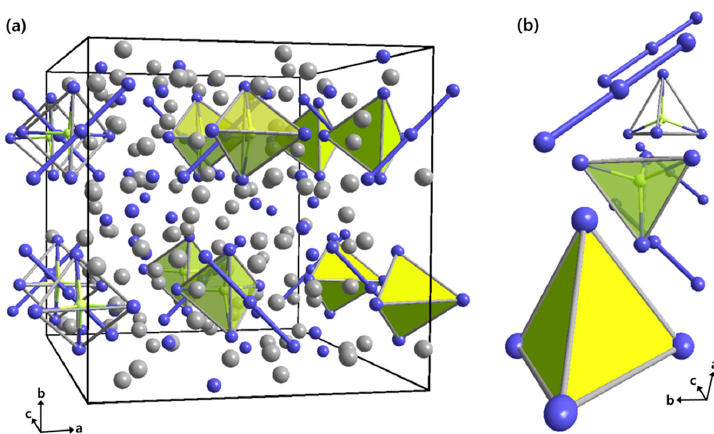
Figure 1. ( a ) Combined ball-and-stick and polyhedral representations of the crystal structure of the